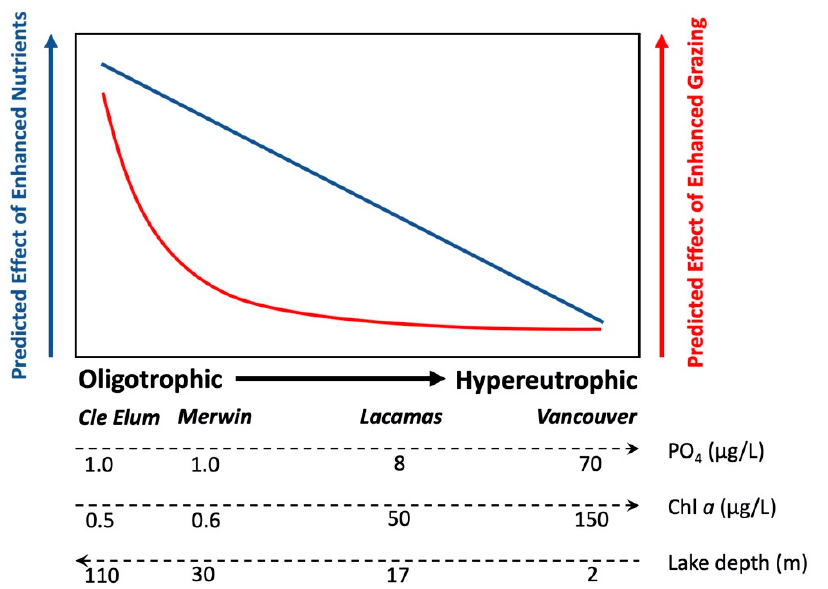
Figure 1. Conceptual diagram showing the level of effect on phytoplankton growth and assemblage structure predicted from the addition of nutrients and mesozooplankton grazers in four lakes of increasing “trophic state,” as indicated by mean concentrations of dissolved PO 4 and chlorophyll (chl) a , and total lake depth.